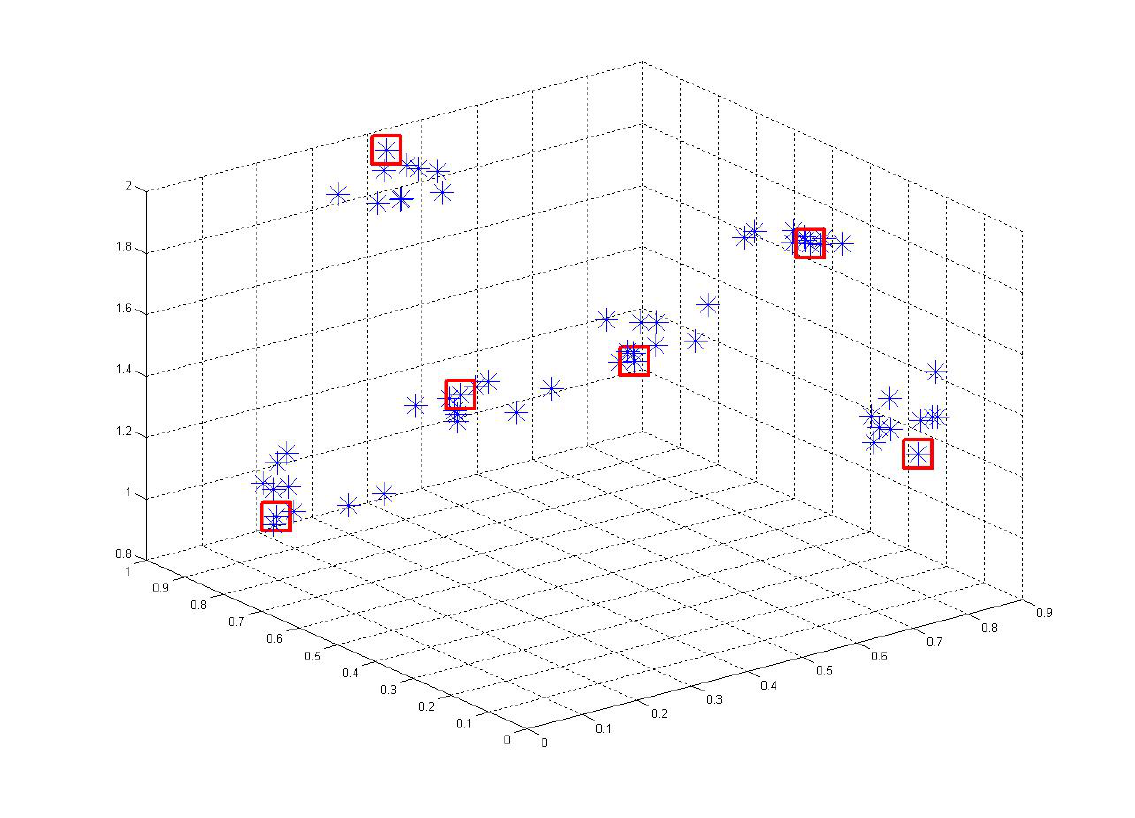
Figure 3: Result on synthetic dataset. Stars are the 3D samples and squares are the distinct patterns we found.